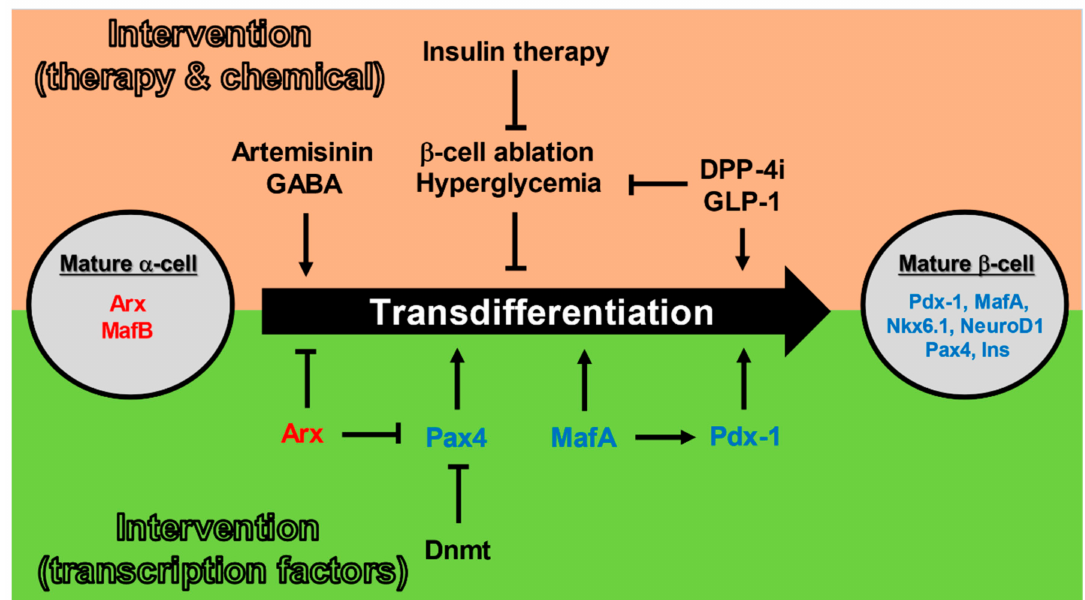
Figure 3. Mechanisms of transdifferentiation from pancreatic α -cells to pancreatic β -cells. Therapeutic interventions with insulin, GLP-1, or DPP-4i, as well as administration of GABA or artemisinin may promote the conversion of α -cells to β -cells. Pax4, MafA, and Pdx-1 (which are mature β -cell markers) may promote the conversion of α -cells to β -cells, while Arx and Dnmt may inhibit the conversion of α -cells to β -cells. Arrows indicate promotion and T arrows indicate